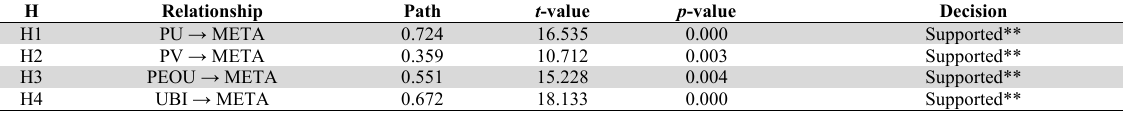
The output of SEM.